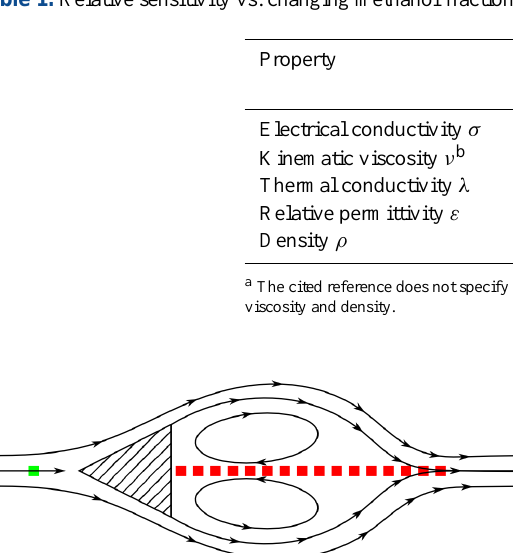
Table 1. Relative sensitivity vs. changing methanol fraction of some physical properties for methanol/water mixtures (at 25 ◦ C).